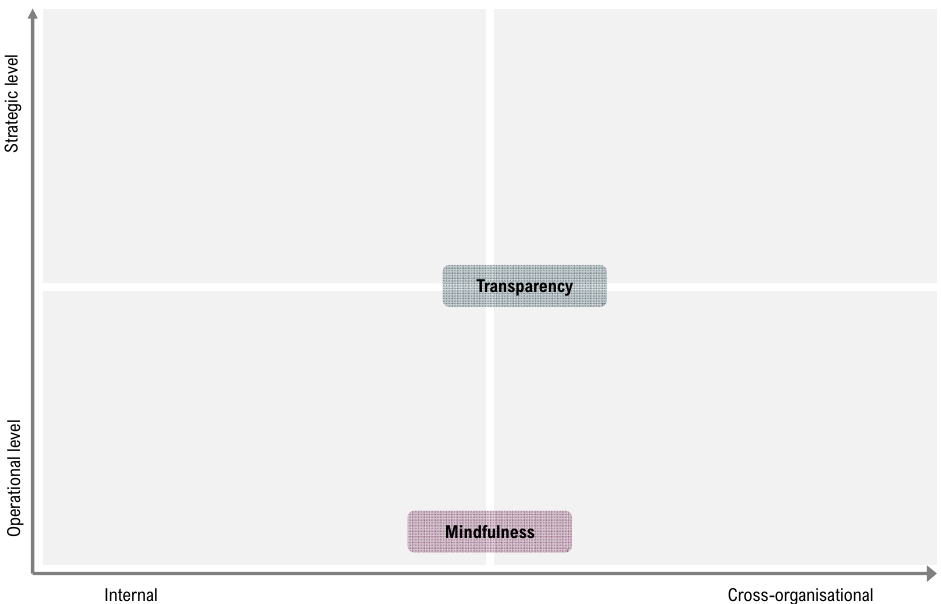
Figure 14. Suggested fields of action for the beginner profile.